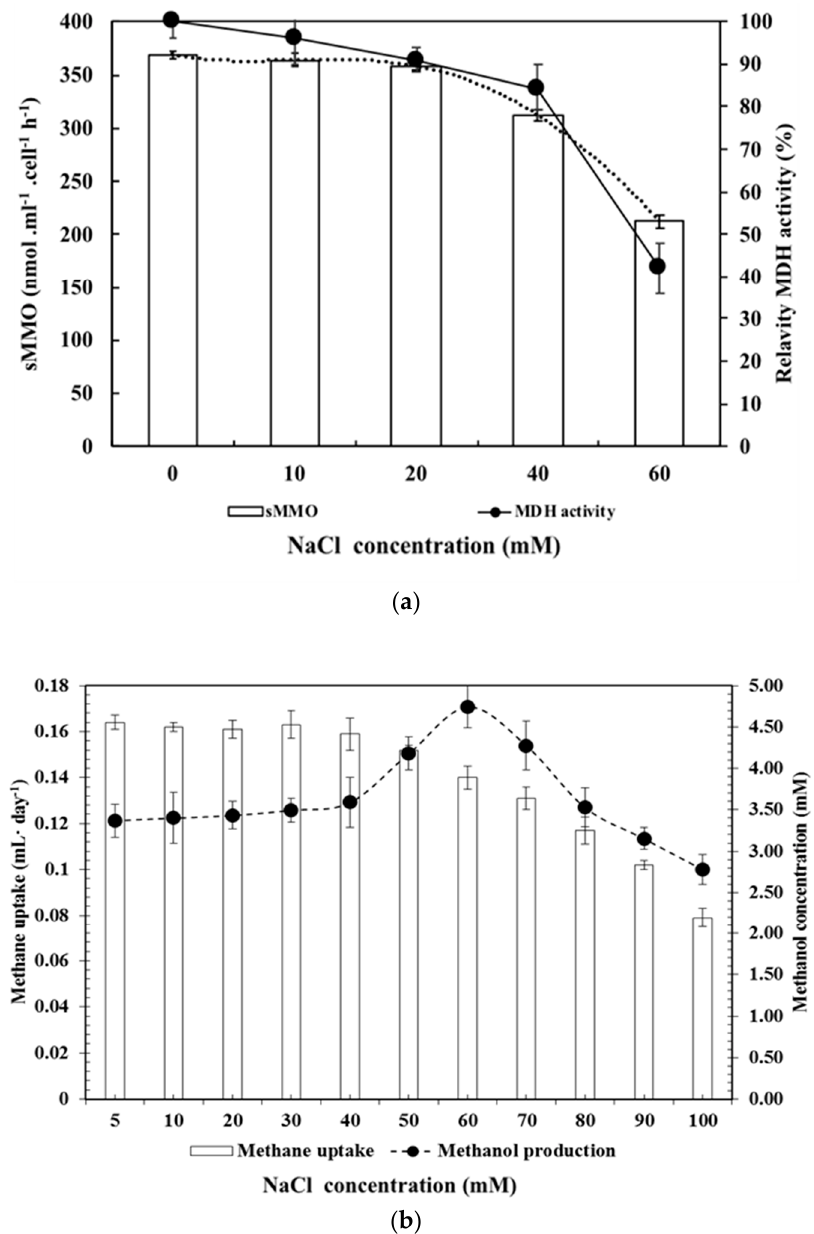
Figure 5. Changes in sMMO expression and MDH activity ( a ) and methane uptake rate and methanol production with respect to NaCl concentration ( b ) in treated wastewater medium.